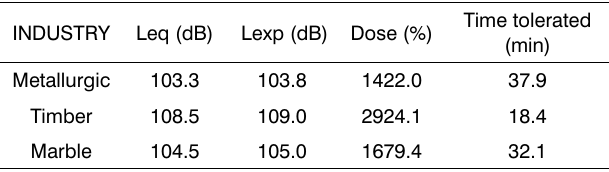
Table 4. Sound pressure equivalent level, daily exposure level, dose and time of maximum exposure tolerated according to the industry,